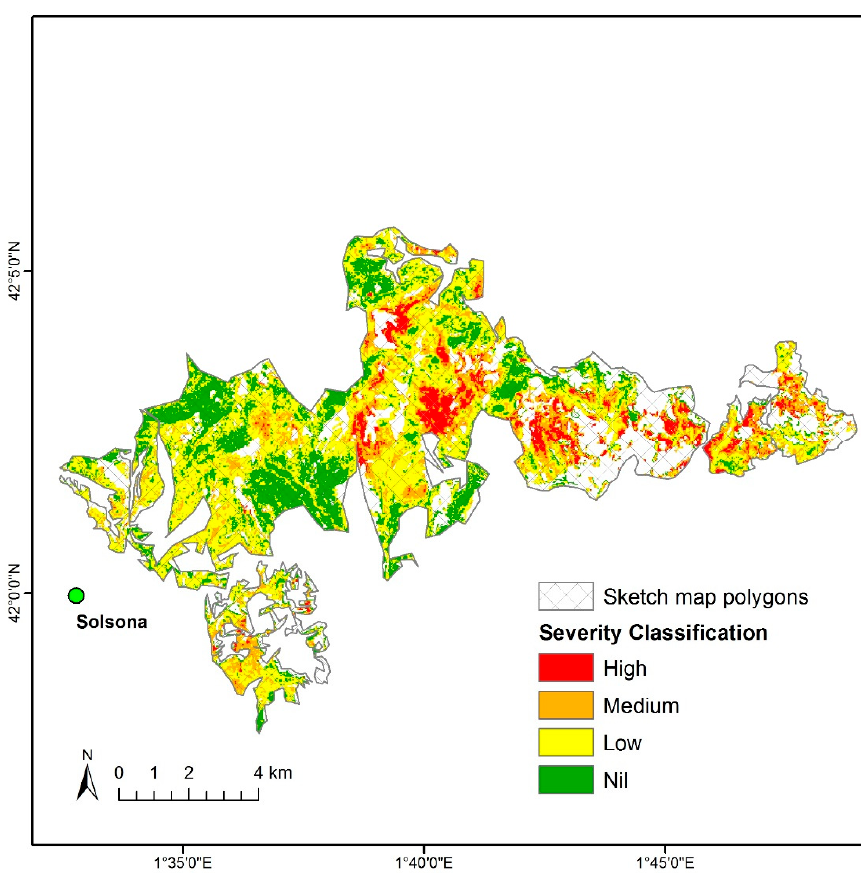
Figure 4. Severity map of defoliation classified by threshold limits of dMSI representing pine-dominant stands (excluding non-forested areas and stands dominated by other tree species). Table 3. Summary of logistic regression models.